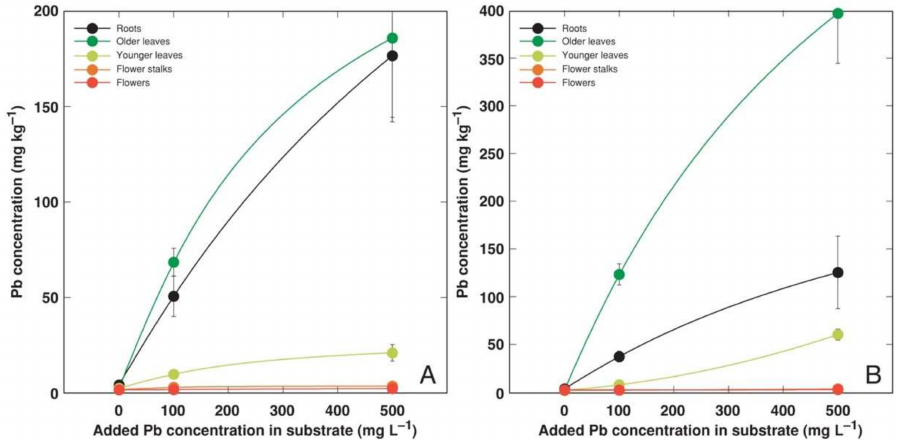
Figure 7. Effect of added Pb concentration in soil on Pb concentration in different parts of Armeria maritima plants of accession AM1 ( A ) and AM2 ( B ) after cultivation for 9 weeks. Data are means ± SE from 3 samples.